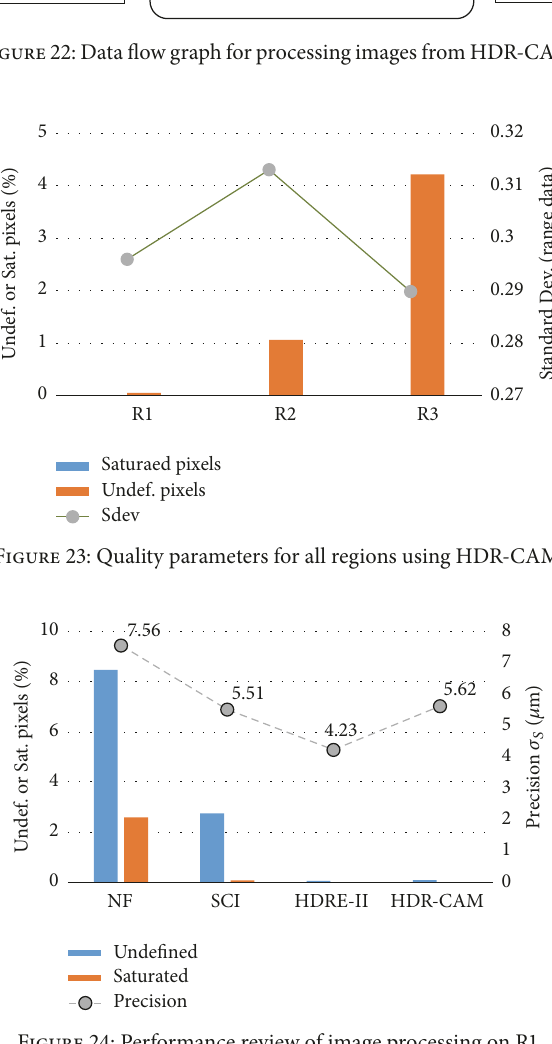
Figure 24: Performance review of image processing on